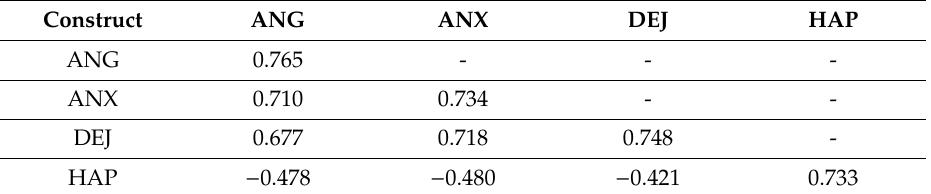
Table 5. Discriminant validity: Fornell–Larcker criterion.